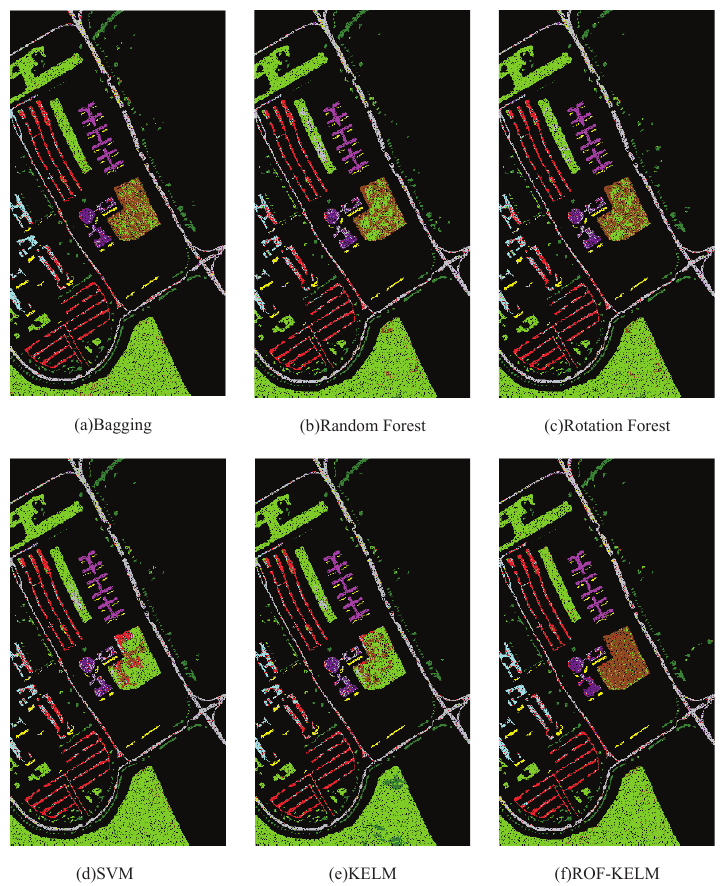
Figure 6. Classification results by different algorithms on ROSIS image